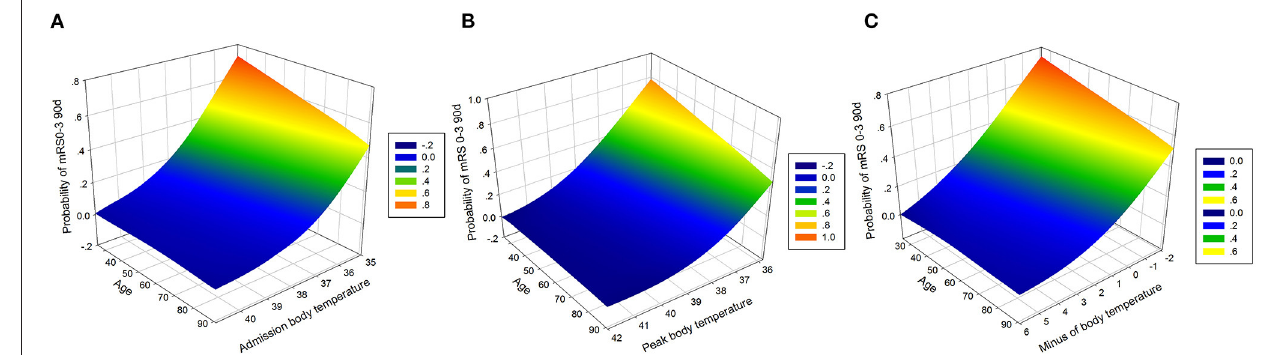
FIGURE 3 | Association of body temperature and age with favorable outcome. (A) Association of admission body temperature and age with the probability of a favorable outcome. Favorable outcome probabilities are stable across ages in a prescribed admission body temperature ( R 2 = 0.9984). (B) Association of peak body temperature and age with the probability of a favorable outcome. Favorable outcome probabilities are stable across ages in a prescribed peak body temperature ( R 2 = 0.9972). (C) Association of minus body temperature and age with the probability of a favorable outcome. Favorable outcome probabilities are stable across ages in a prescribed minus body temperature ( R 2 =